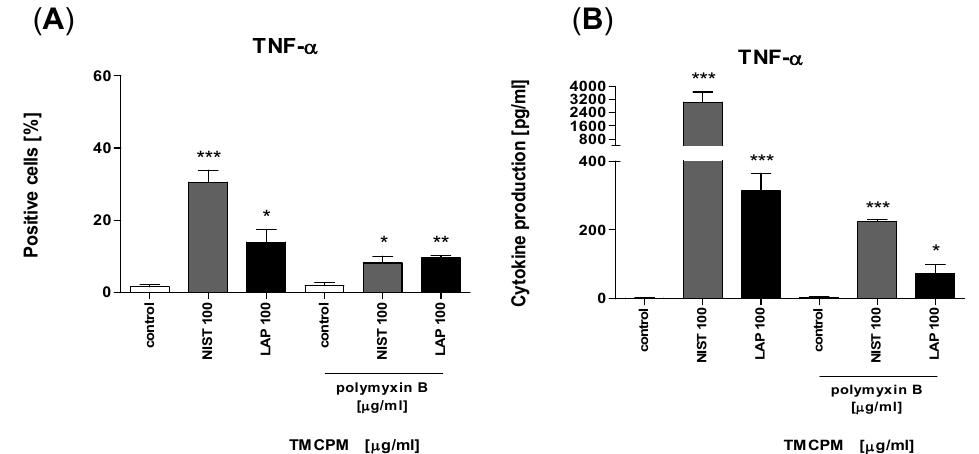
Figure 9. Effect of LPS inactivation in TMCPM (NIST and LAP) on TNFα production by purified human monocytes. Monocytes were stimulated for four hours with NIST or LAP (100 μg/mL) with or without pre-treatment with polymyxin B (100 μg/mL). Percentage values of TNF-α positive monocytes ( A ) was analyzed by flow cytometry after the cells were stained with fluorescently conjugated monoclonal antibodies. Concentration of TNF-α ( B ) in culture supernatants were determined by CBA. Data are presented as mean ± SEM. The figure shows the results from three independent experiments. Differences between the groups were considered statistically significant at the following p values: * p < 0.1, ** p < 0.01, *** p < 0.001.